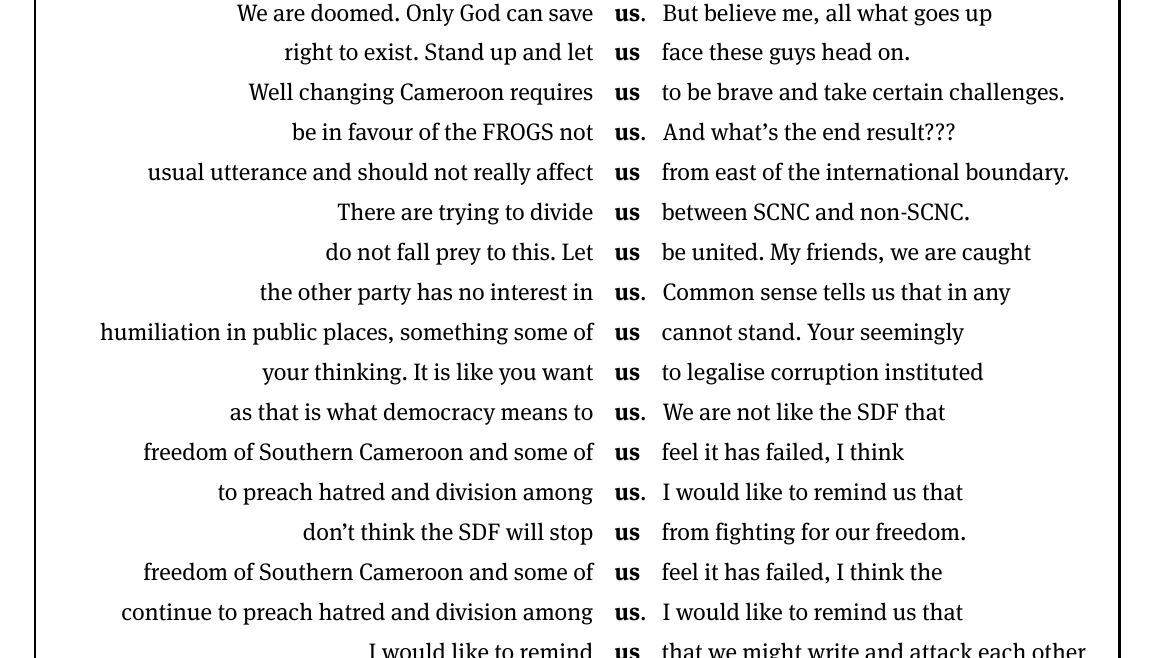
Figure 5. Sample concordance list for